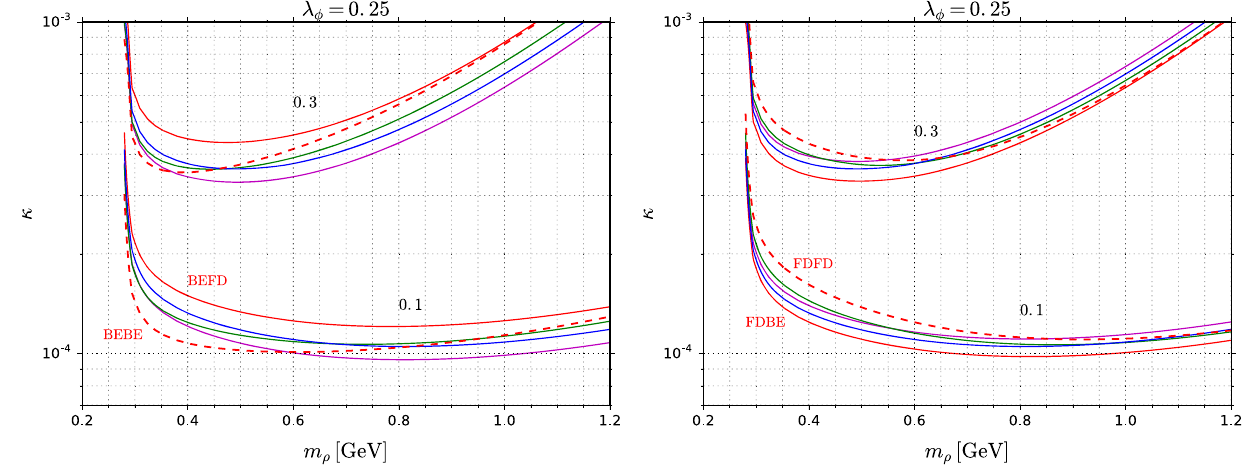
Fig. 4 Contour lines of constant (cid:3) N eff (top lines: 0.3, bottom lines: 0.1) in ( m ρ , κ ) plane for λ φ = 0 . 25 and bosons/fermions annihilation (left/right panel). Continuous (dashed) red lines correspond to mixed (homogeneous) statistics – see Eqs. (53) and (54) e.g. BEBE case refers